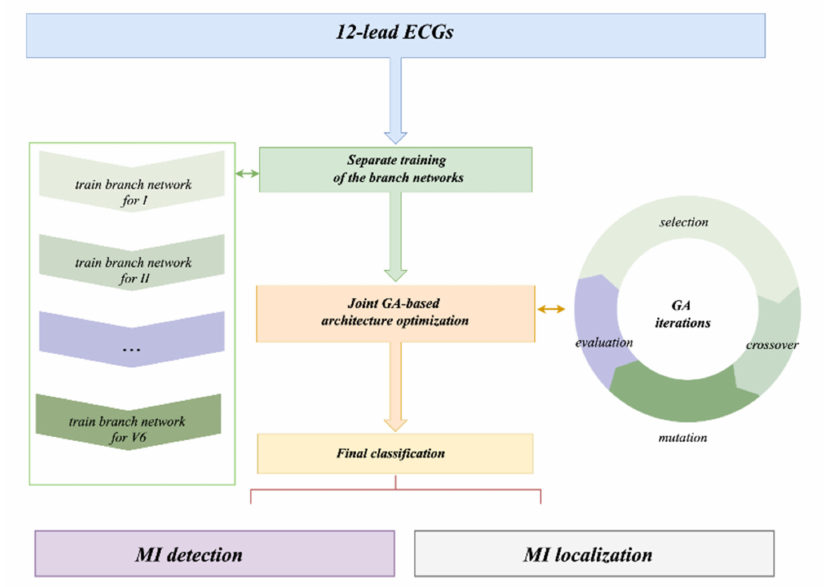
Figure 4. A flowchart of the proposed